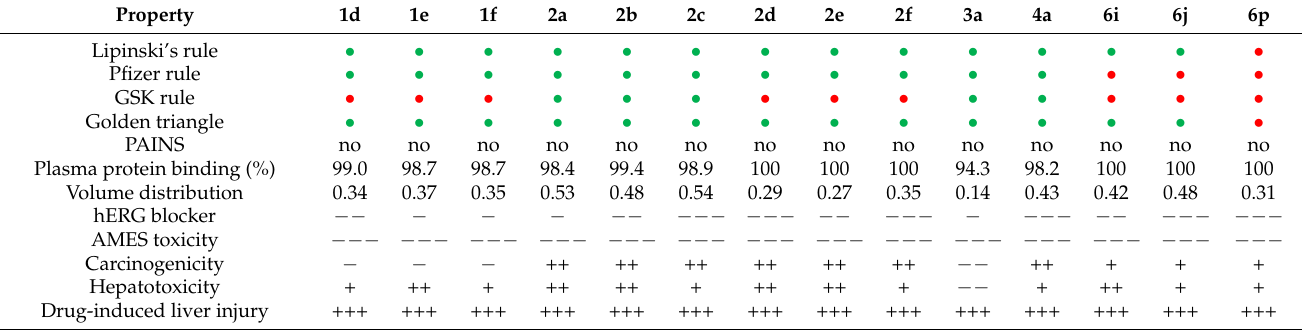
Table 5. ADMET predictions for the new compounds 1d–f ; 2a–f ; 3a ; 4a ; 6i,j ; and 6p . yes for green, no for